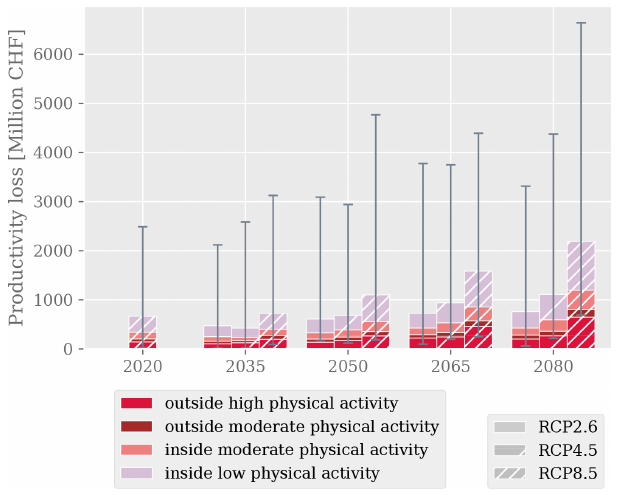
Figure 5. Median of the labour productivity losses calculated in the Monte Carlo simulation for the baseline (2020, RCP8.5) and the years 2035, 2050, 2065, and 2080 under the three RCP scenarios. The uncertainty estimate corresponds to the 90% confidence inter- val.